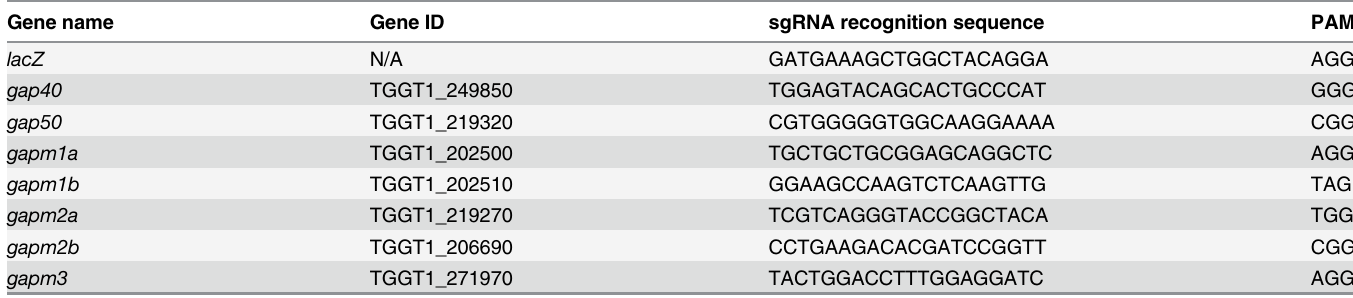
Table 2. List of gRNAs used in this